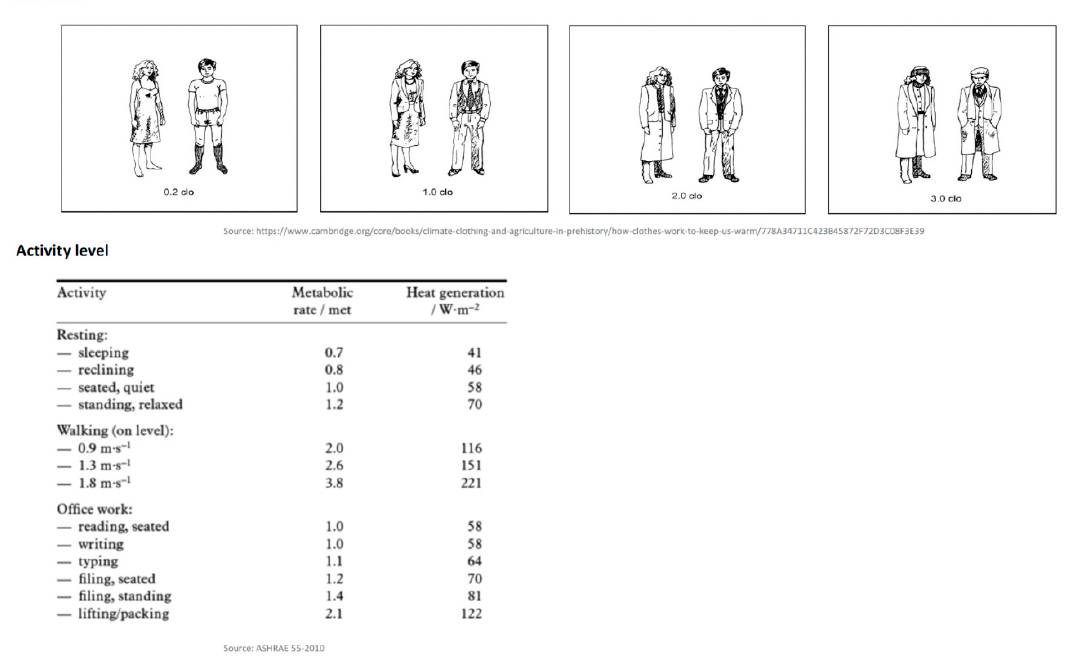
Figure A2. Reference Material as a part of Online Questionnaire during the educational workshops (Part 4). (Part